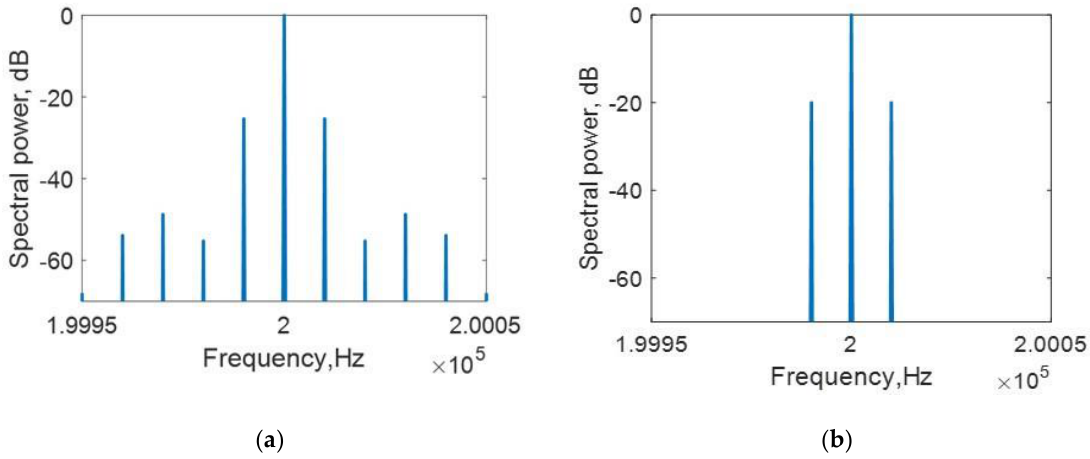
Figure 13. Simulation spectrum ( a ) of the bilinear and ( b ) quadratic crack models.